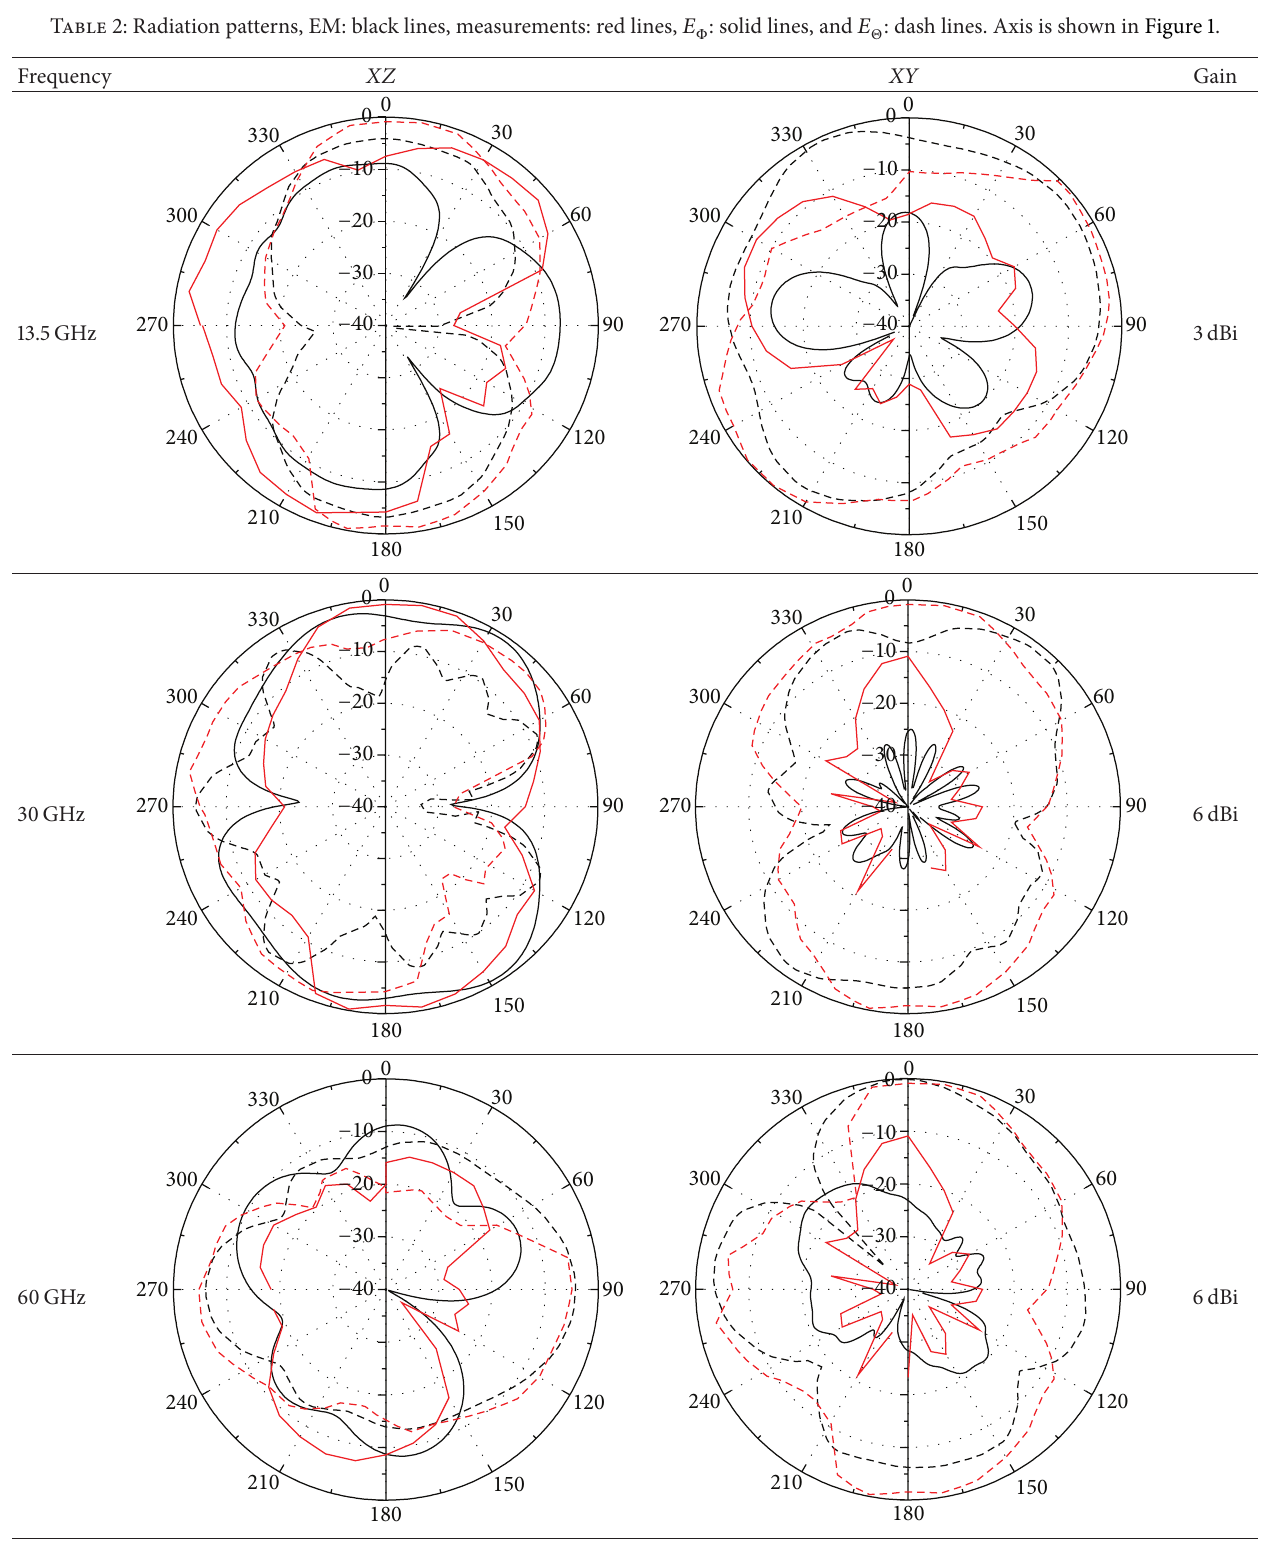
Table 2: Radiation patterns, EM: black lines, measurements: red lines, 𝐸 B : solid lines, and 𝐸 Θ : dash lines. Axis is shown in Figure 1. Frequency 𝑋𝑍 𝑋𝑌 Gain